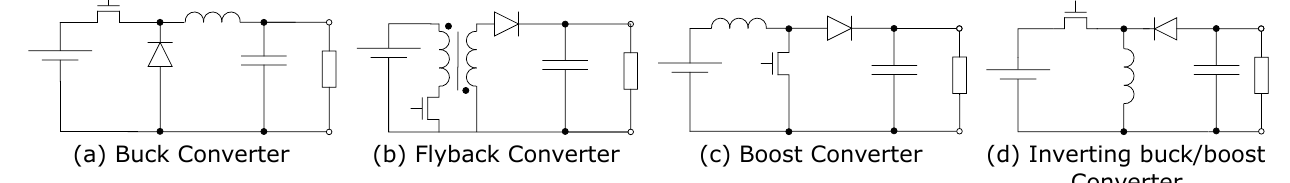
Figure 1. Basic schematic of different converter types. ( a ) Buck; ( b ) flyback; ( c ) boost; ( d ) inverting